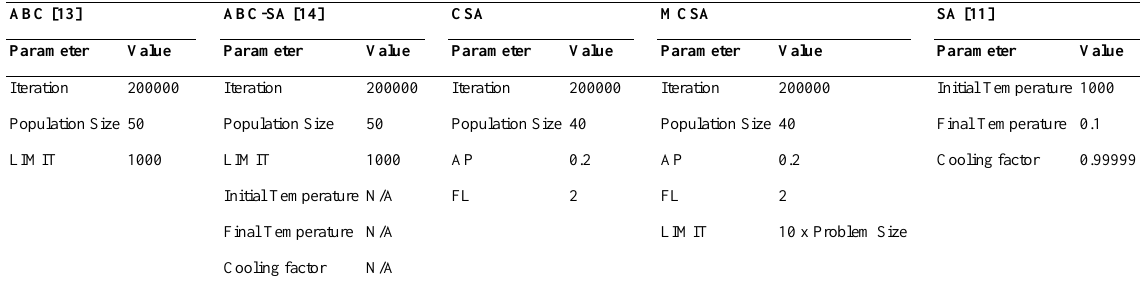
Table 3. Parameter settings for all algorithms.